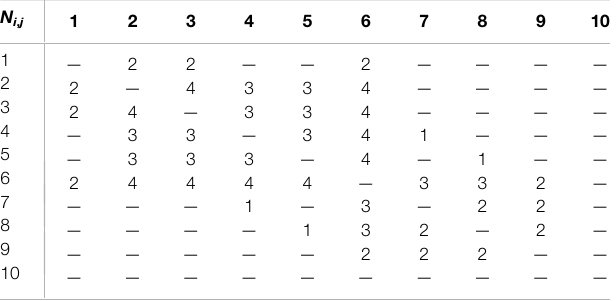
TABLE 2 | The ( N i , j ) number of different (undirected information fl ow) paths between two nearest neighbors i and j , through a nearest neighbor k . N i ,